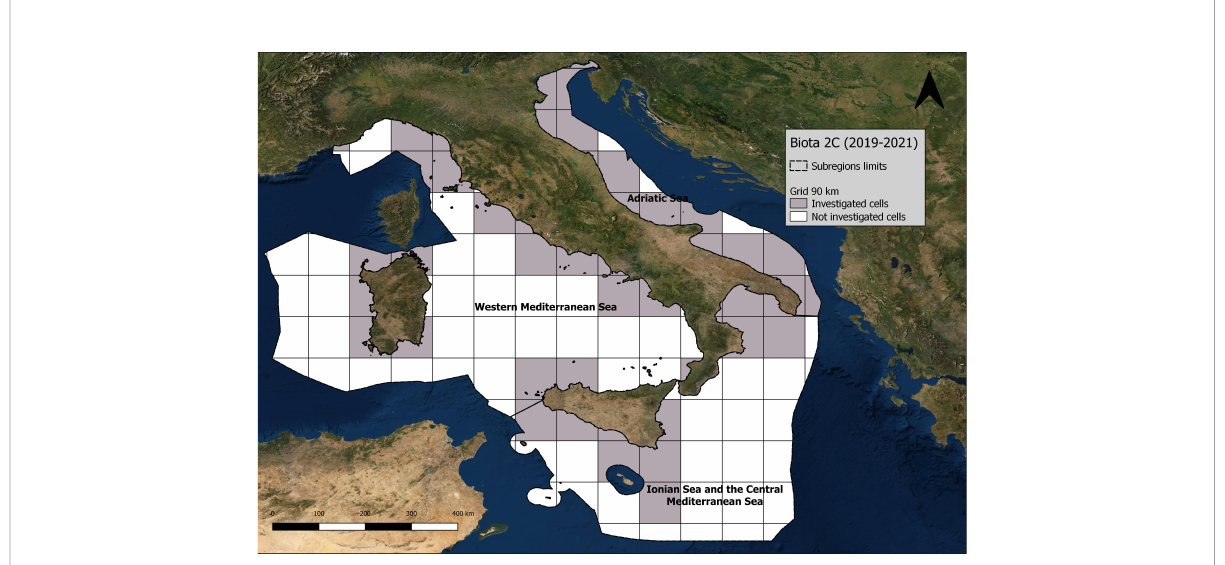
FIGURE 6 Coverage of biota sampling in all Italian subregions in the second cycle of MSFD (2019 –